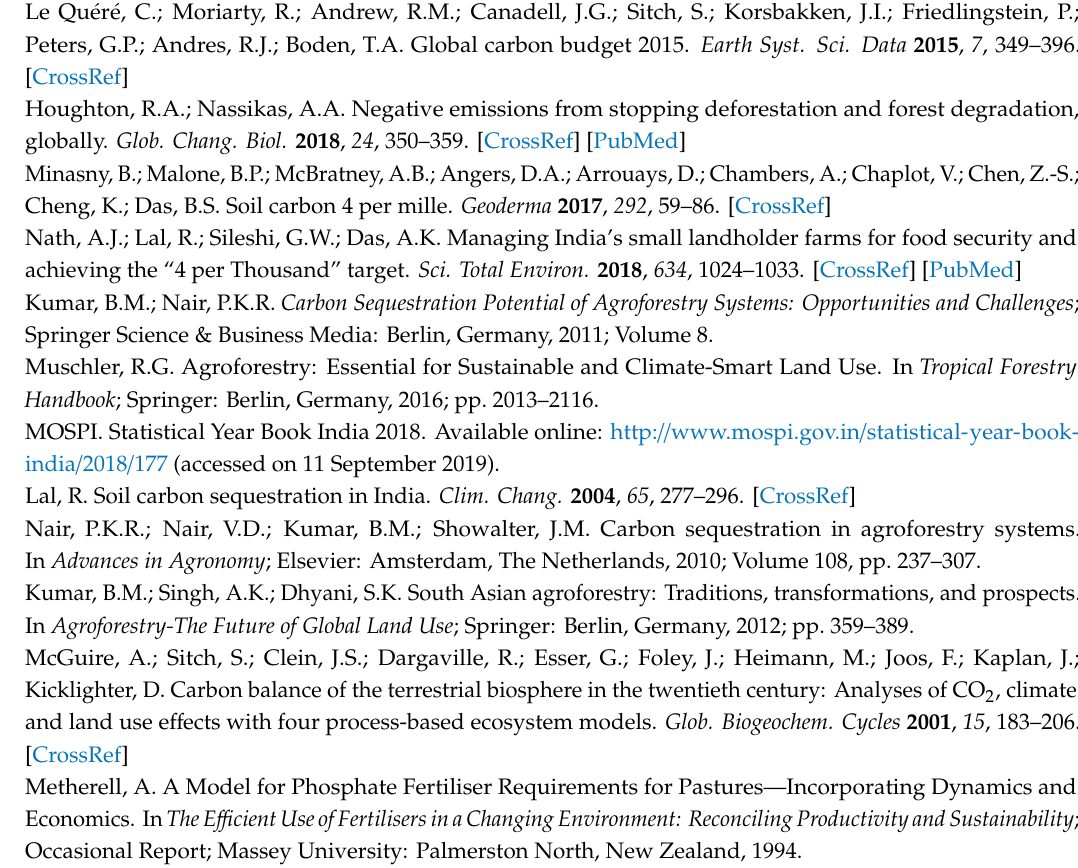
Table S1: Climate data from the Vellanikkara, Thrissur Station. Latitude: 10 ◦ 31’; Longitude: 76 ◦ 13’. Height is 40 m above MSL. Monthly data from January 1983 to September 2005, Table S2: Schedule’ file in CENTURY. Blocks #1–4 simulate the land-use scenario, i.e., the ‘spin-up,’ prior to the start of the experimental modeling. Block #5 simulates the first run in Experiment #1 on e ff ects of cropping system for the treatment of 100% Annuals (Banana, plantain), Table S3: Tree parameters in the Tree.100 file. Table S4: Crop Parameters in the ‘Crop.100’ file, Table S5: Climate parameters used in Experiment 3 on e ff ects of increase in temperature. Point # refers to the order of the temperature increase, from lowest to highest. Bolding denotes parameters that di ff ered among the ‘treatment’ levels. Point #1 values are based on the actual climate data, i.e., no warming e ff ect, Table S6: Site parameters used in Experiment 4 on the e ff ect of soil type. Point # refers to the order of increase in sand content, from lowest to highest. Bolding denotes parameters that di ff ered among the ‘treatment’